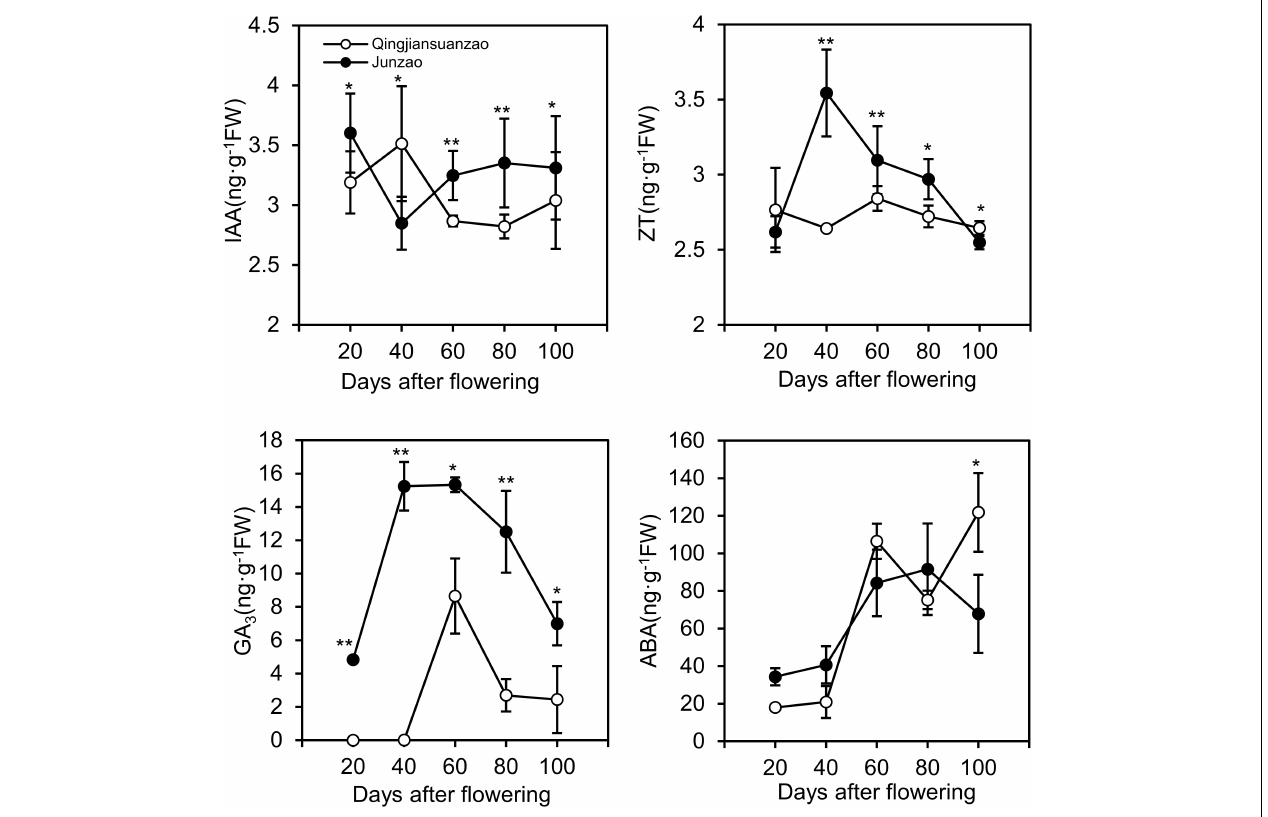
FIGURE 2 | Dynamics of phytohormones IAA, ZT, GA 3 , and ABA during fruit development and ripening in jujube cultivar ‘Junzao’ and wild jujube ‘Qingjiansuanzao’. Values are means of three biological replicates ± SD. * and ** indicate significant differences at levels of p < 0.05 and p < 0.01 by t -test,